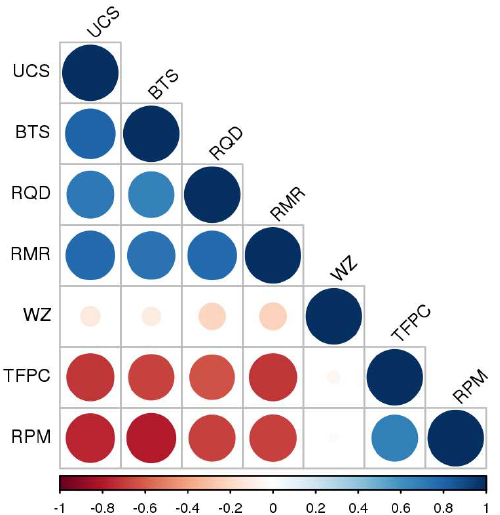
Figure 2. Correlation matrix for input variables.